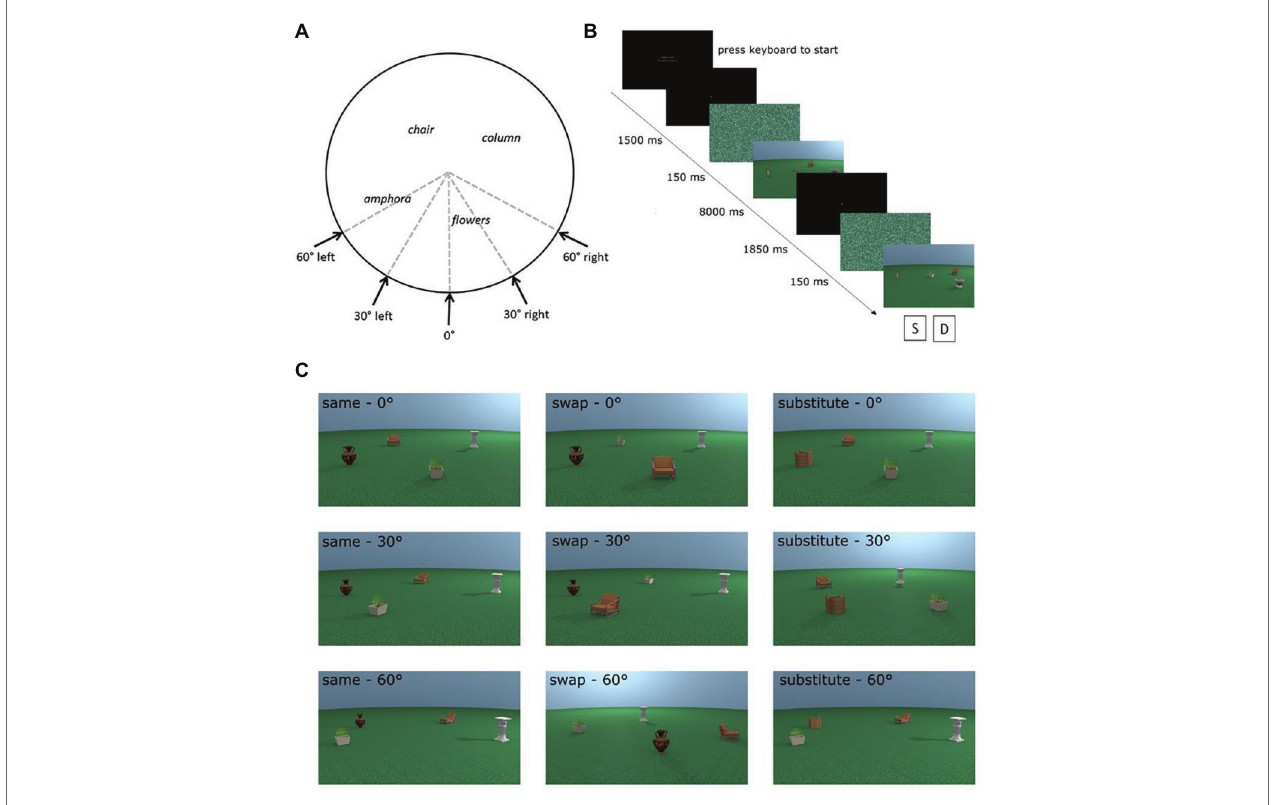
FIGURE 1 | Adapted from Muffato et al. (2019). (A) Overhead schematic of the different possible viewpoints a test place could be shown from. Encoding places were always shown from the 0 ° viewpoint. (B) Sequence of a trial in the experiment. (C) Examples of all possible test conditions for one encoding place incorporating manipulation (swap or substitute) and perspective shift (0 ° , 30 ° , and 60 °